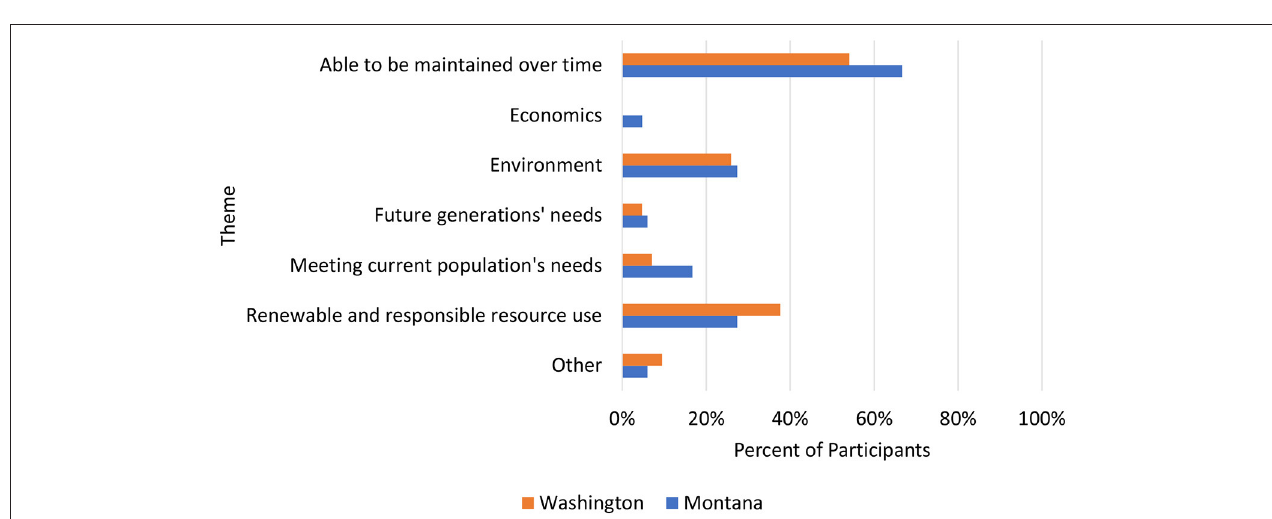
FIGURE 6 | The percent of participants from Washington ( n = 85) and Montana ( n = 83) whose definitions of sustainability contained each of the six identified themes.